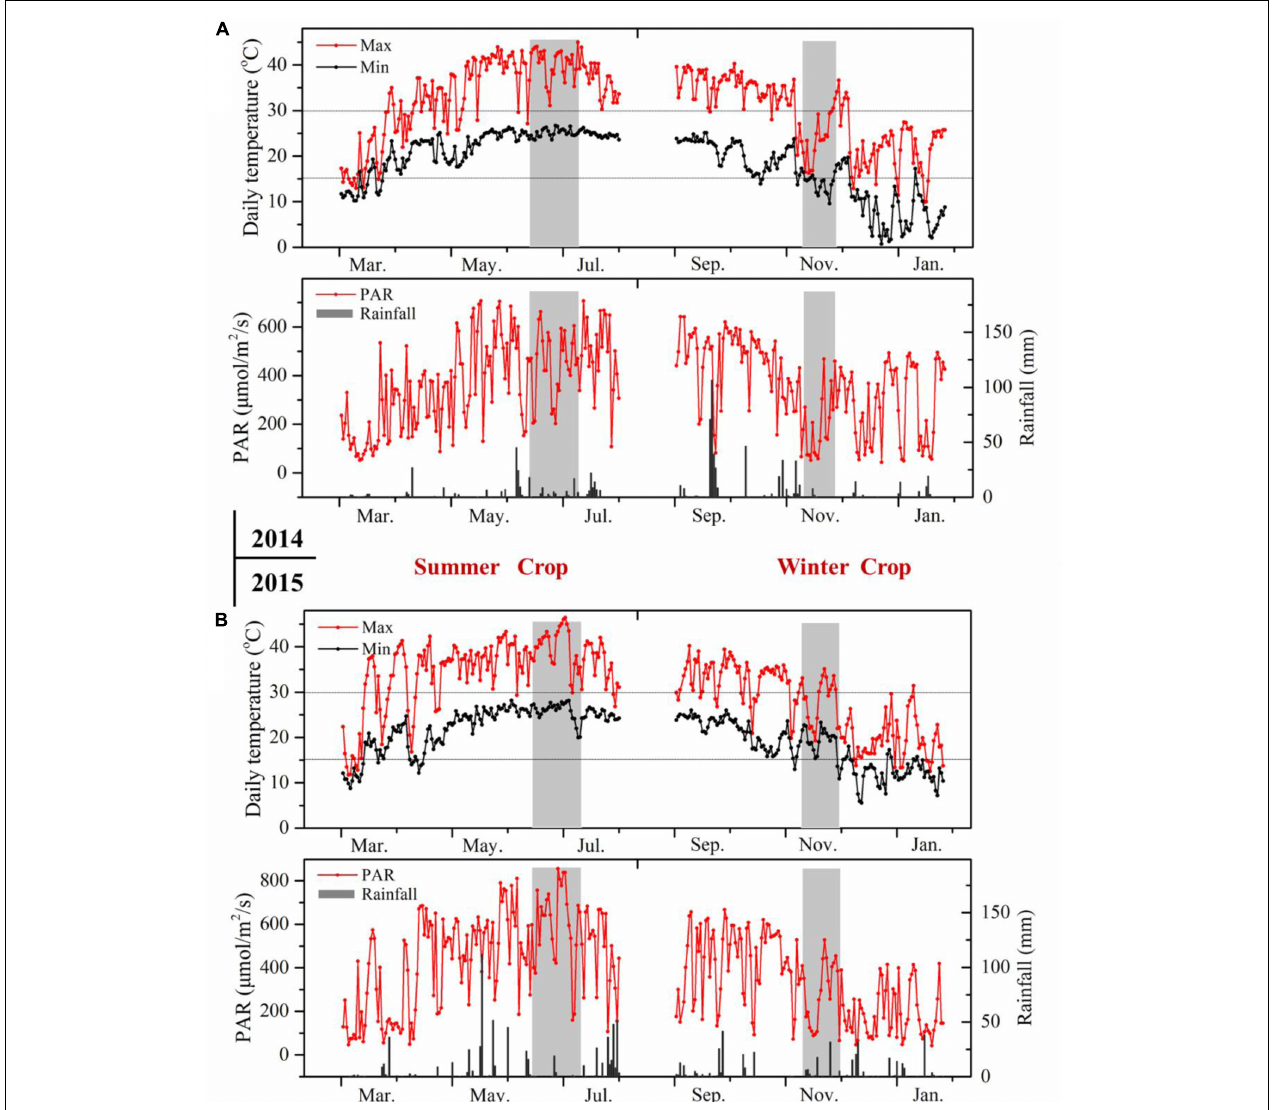
FIGURE 2 | Meteorological data of the vineyards during grape berry development in 2014 (A) and 2015 (B) . The pink rectangle indicates veraison stage from E-L 35 to E-L